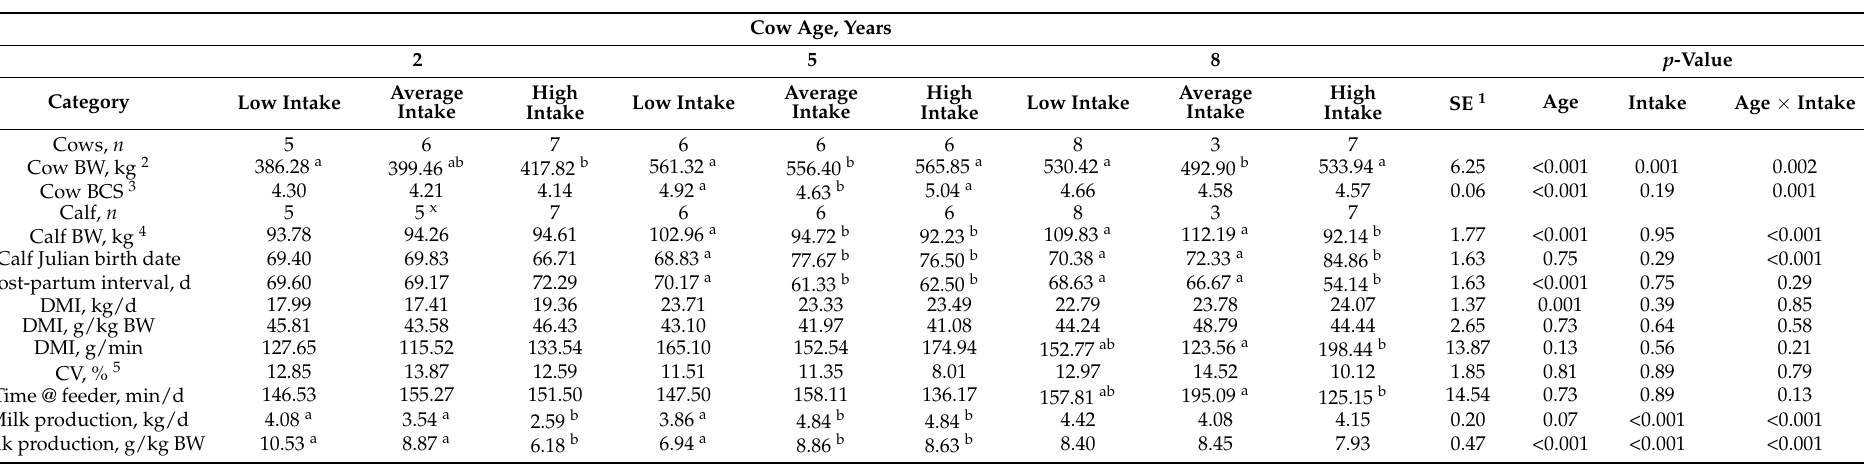
Table 2. The influence of heifer post-weaning intake expressed as grams per kg of BW on subsequent beef cow performance of three age classes of non-pregnant, lactating beef cows (Study